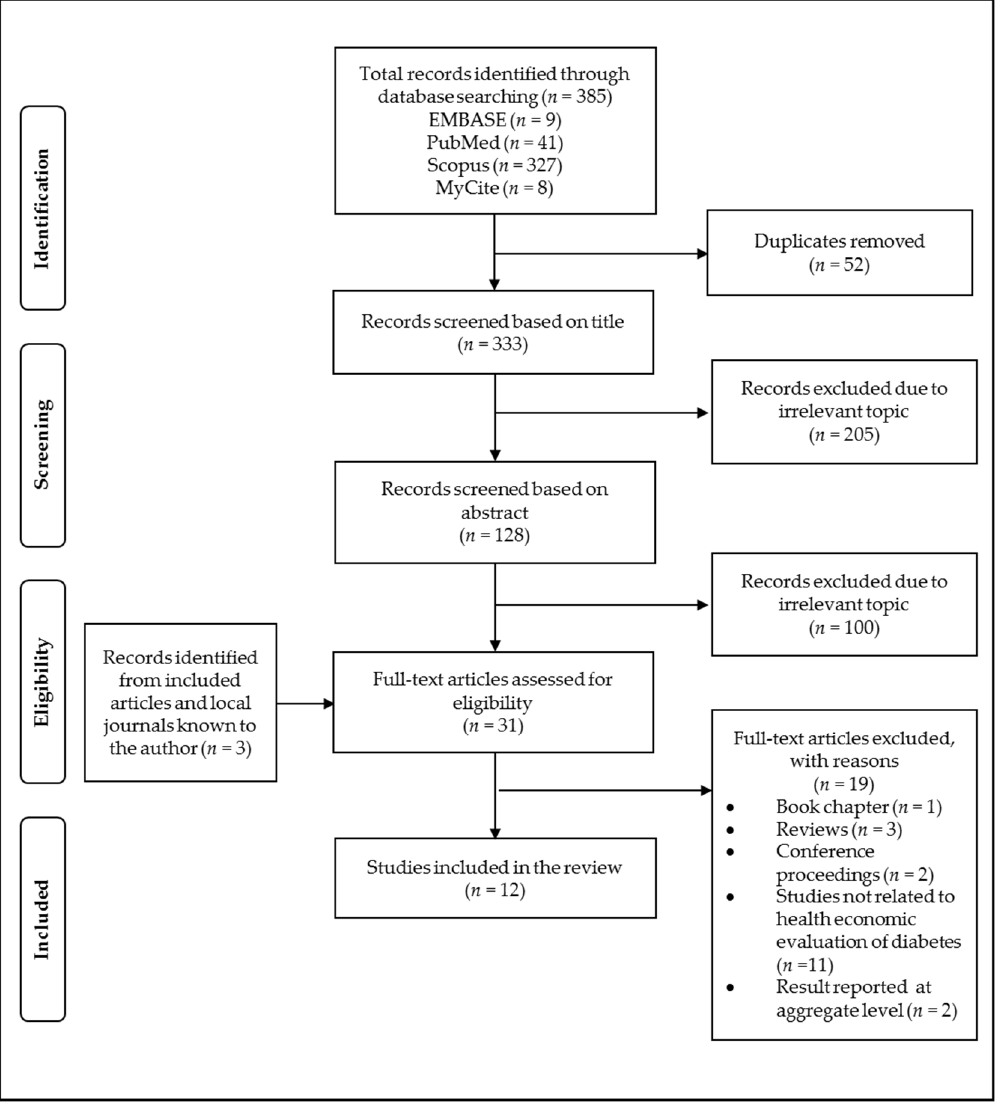
Figure 1. Preferred Reporting Items for Systematic Review and Meta-Analyses (PRISMA) flowchart of the study selection process.